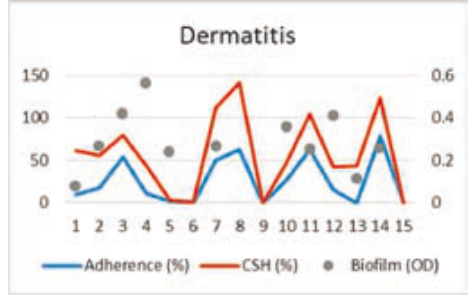
Fig. 7 . Determinants in dermatitis